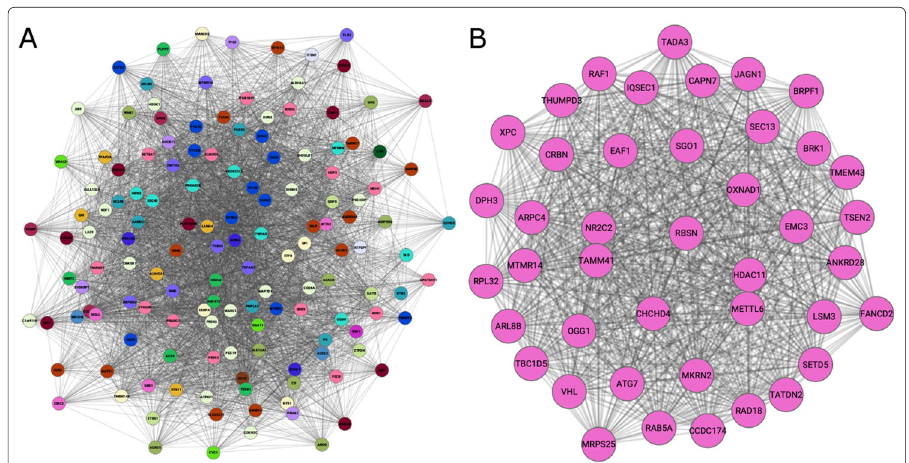
Fig. 5 Main k -core (or simply, cores) of a healthy, and b Basal GCNs. The color of genes is associated with the chromosome to which they belong. In the case of the Basal main core, all genes blong to chromosome 3, meanwhile in the healthy core, its 142 genes are shared between all